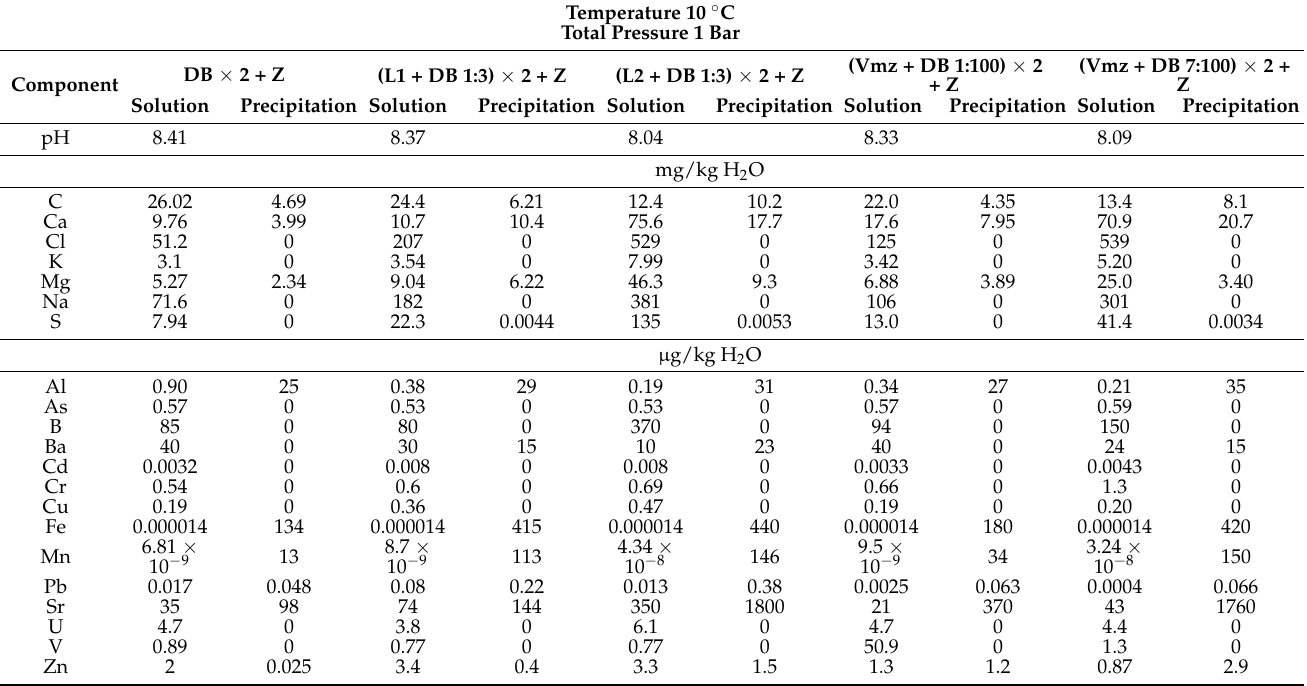
Table 3. Simulation results of changes in composition of water in Zolotitsa River with discharged drainage groundwater from a system of dewatering